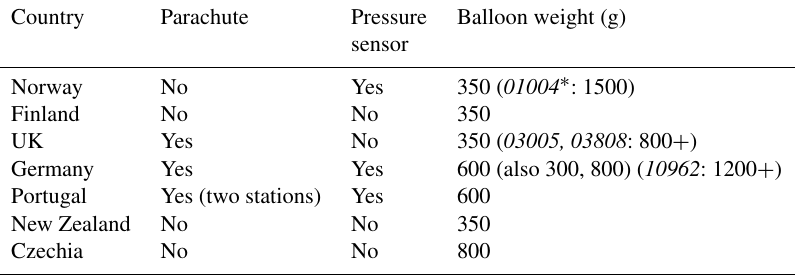
Table 1. Summary of metadata for countries providing descent data in 2019. For balloon weight, the most common value is given; other weights used are given in parentheses, usually with an indication of the stations involved. World Meteorological Organization station identi- fiers are shown using italic font. The names/locations of the stations can be found at https://oscar.wmo.int/oscar/vola/vola_legacy_report.txt (last access: 4 January 2022). The Czech data were not provided to ECMWF in real time, but they are analysed in Sect. 4.